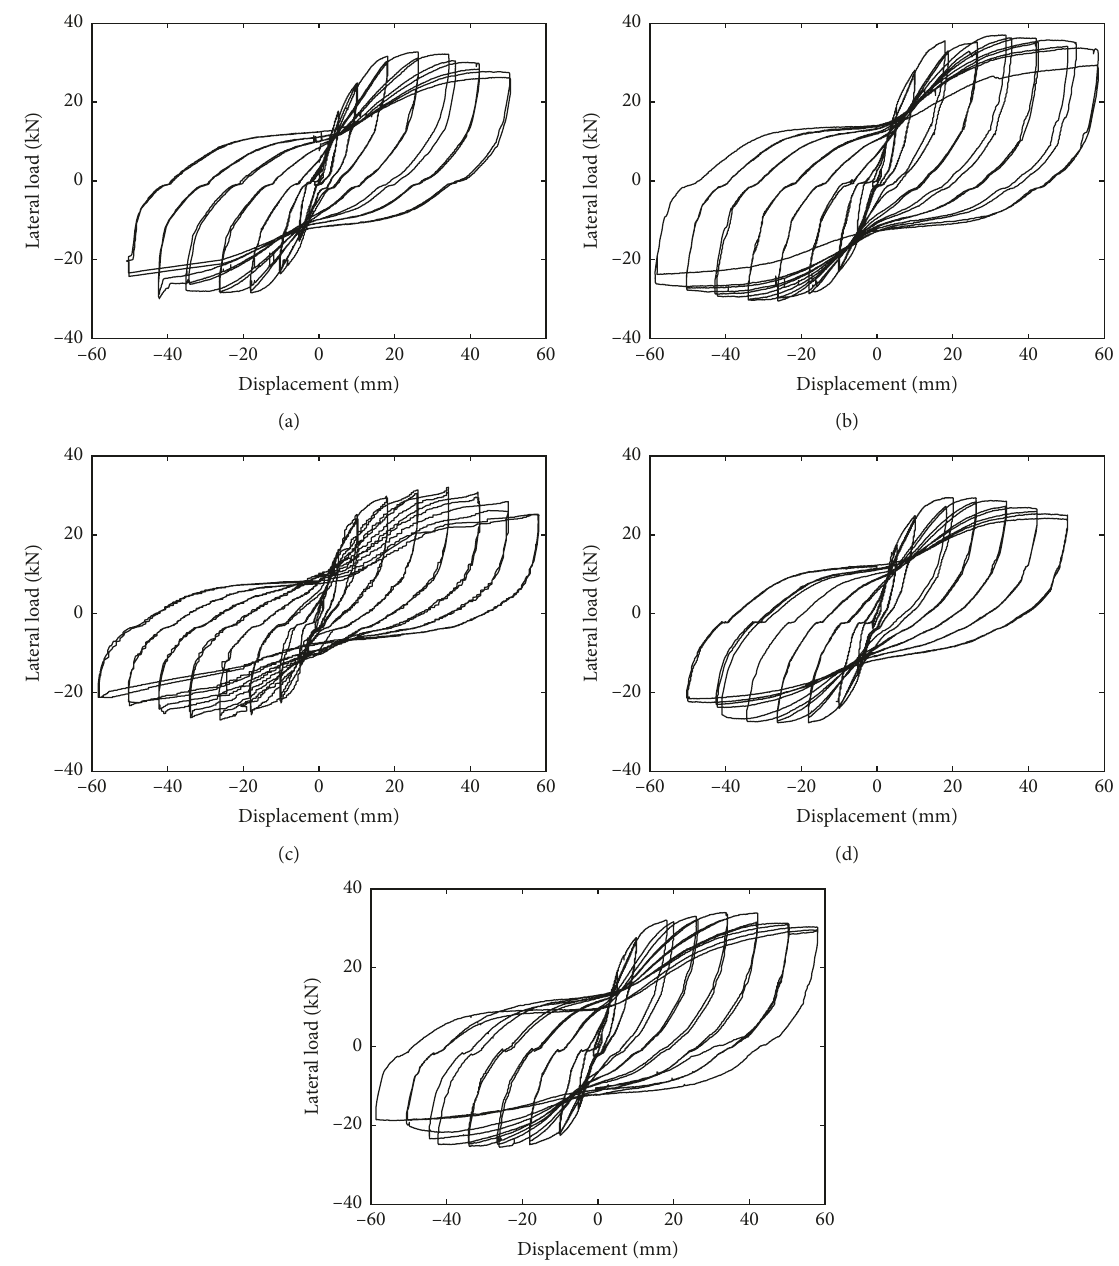
Figure 6: Tested hysteresis curve of columns: (a) NU-1; (b) NU-2; (c) LU-2; (d) NC-1; (e)